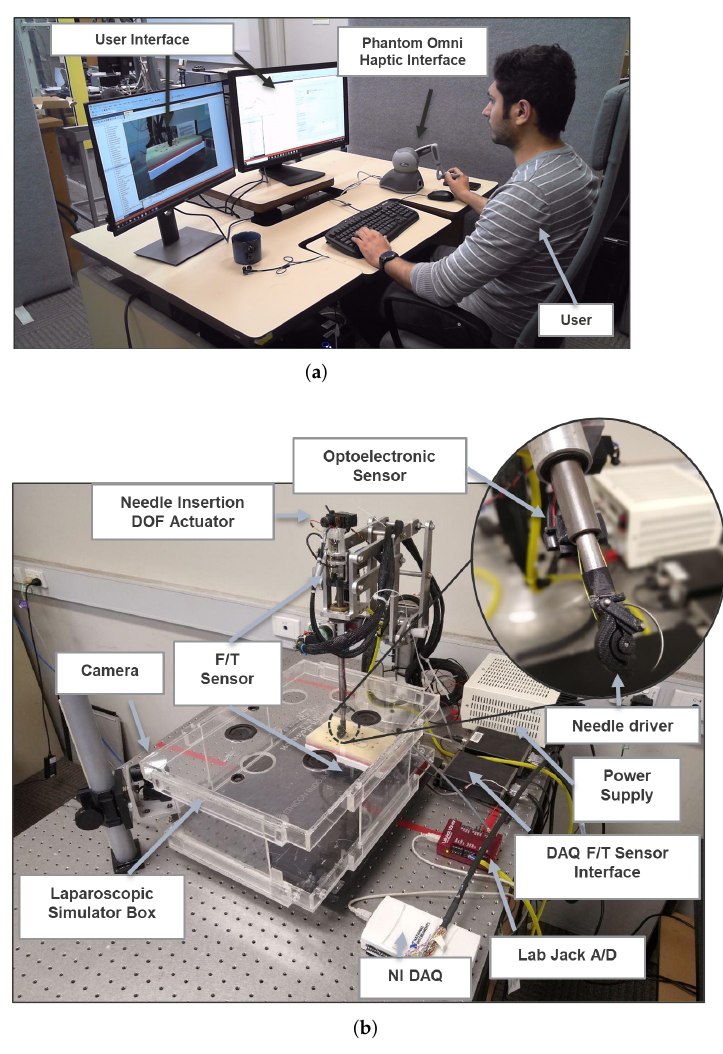
Figure 7. Experimental research facility: ( a ) user interface and haptic device; ( b ) teleoperated robotic surgical system